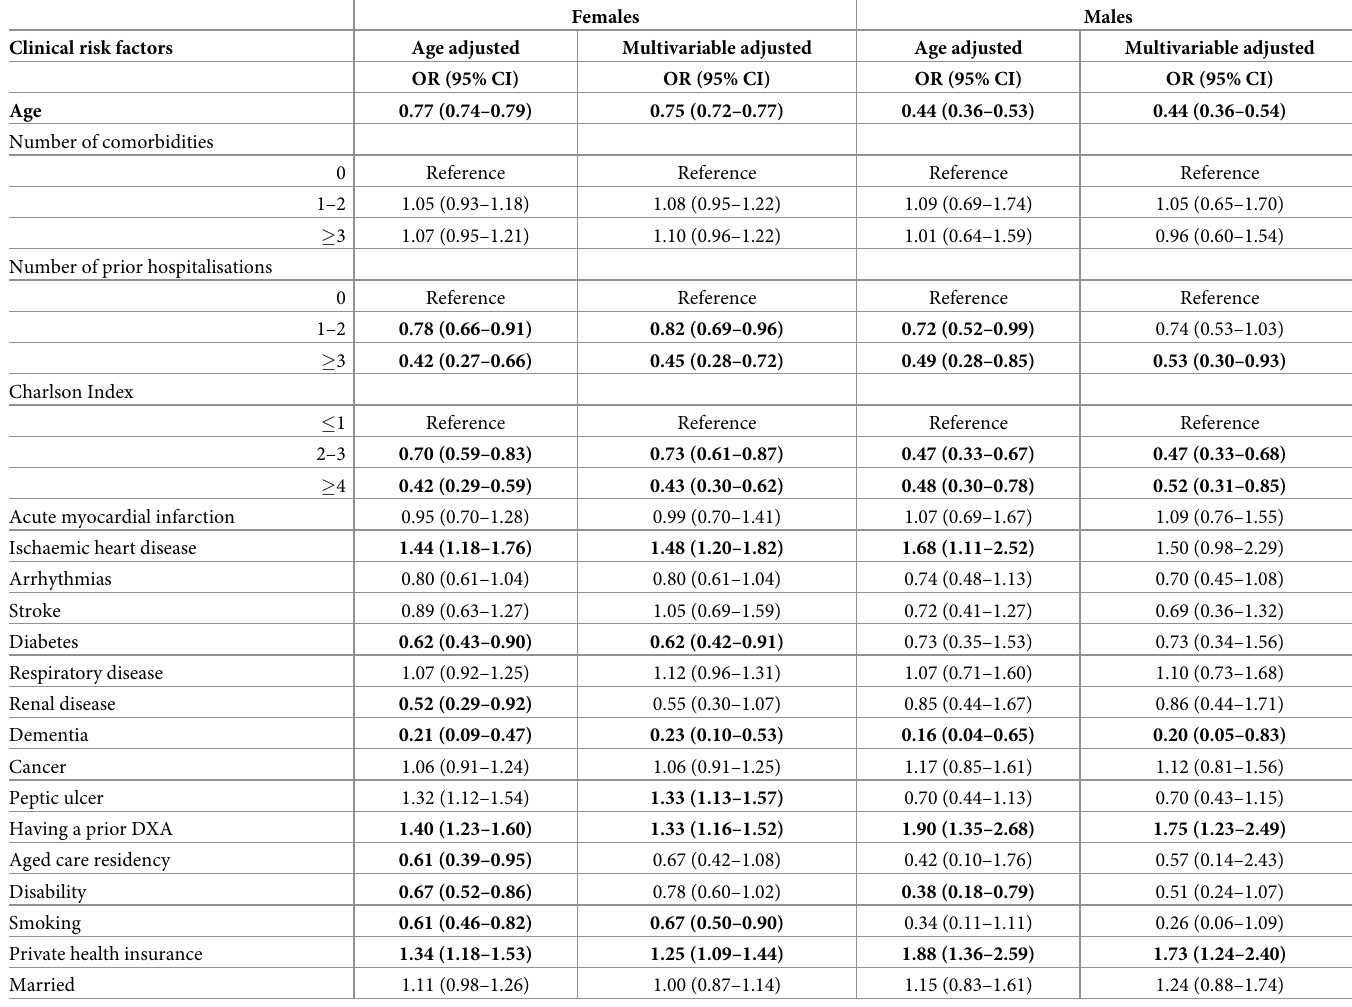
Table 2. Clinical risk factors associated with DXA investigation following index fracture in the high-risk group. Females